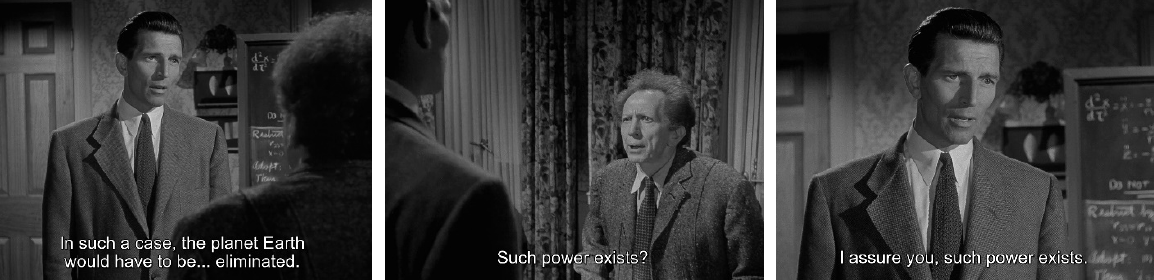
Figure 4. The shocking Klaatu–Barnhardt exchange. The Day the Earth Stood Still © 20th Century Fox. All Rights Reserved.